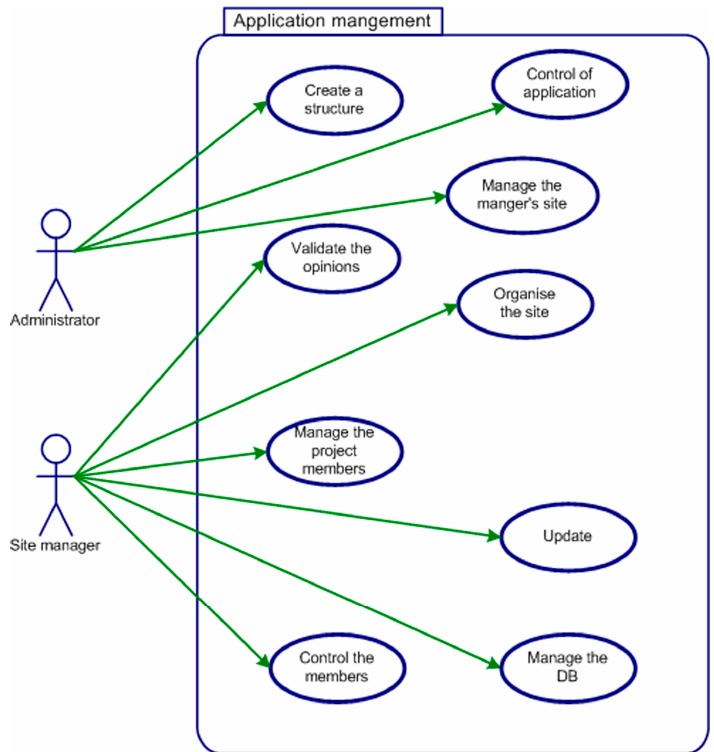
Figure 15. The behavior of not connected public members within the